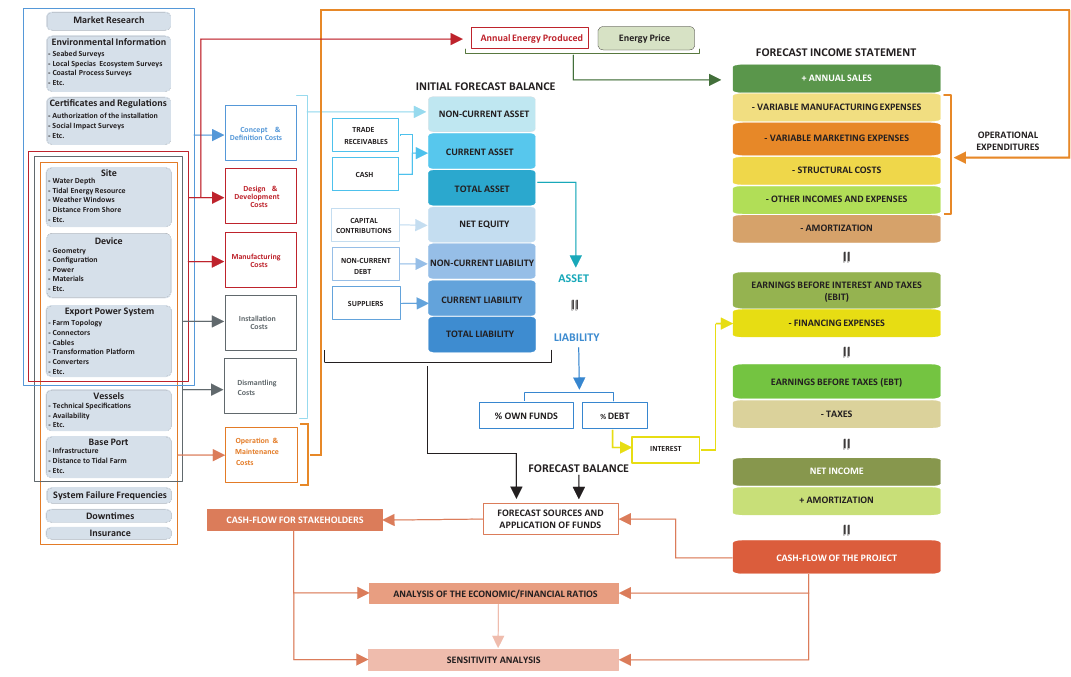
Figure 11. Economic-financial model for gravity-based tidal energy